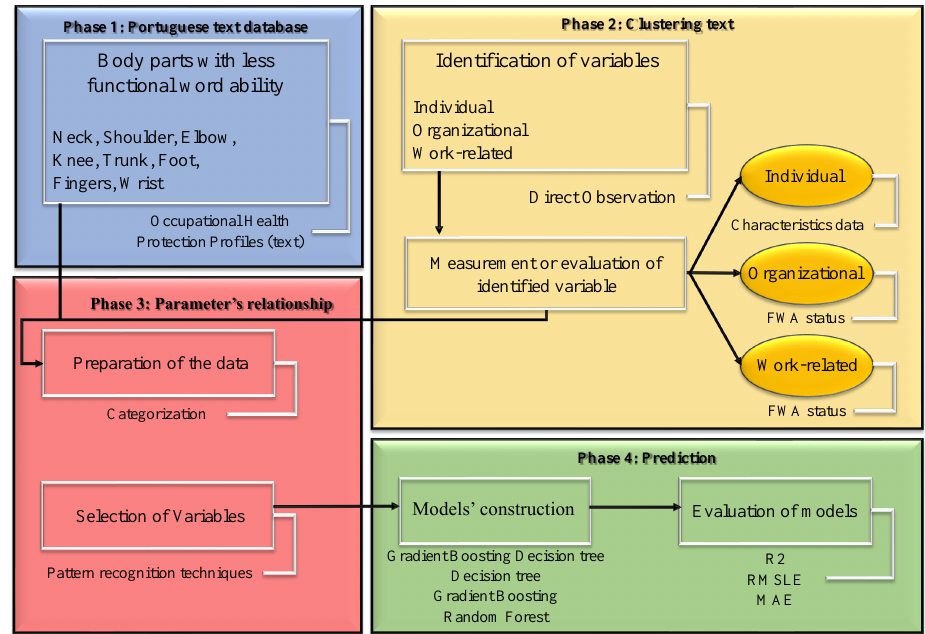
Figure 4. Phases of the method process used in this